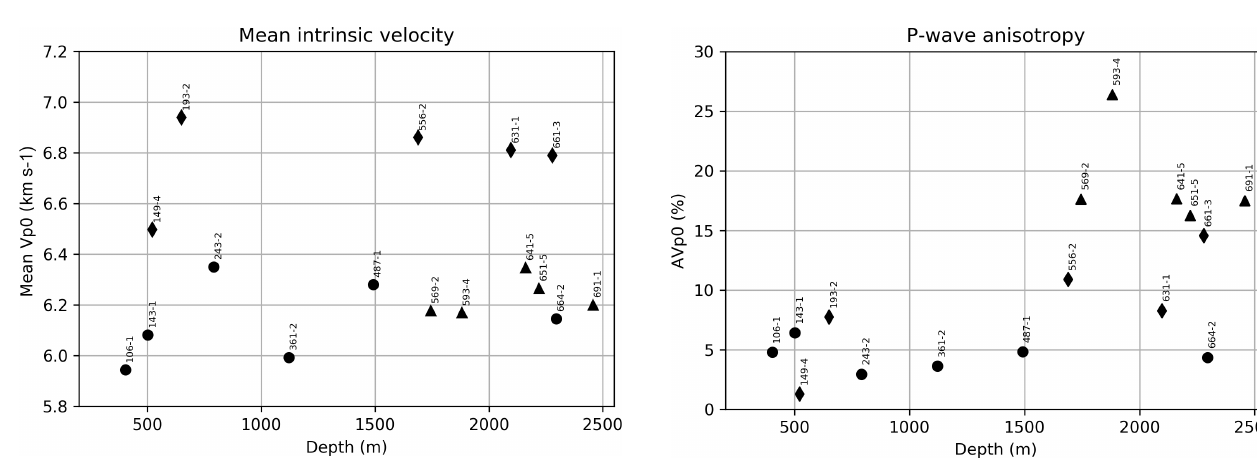
Figure 9. Seismic anisotropy measured in 16 rock samples from the COSC-1 borehole plotted at the respective sample depth. Mark- ers correspond to simplified lithological classes such as mafic amphibole-rich units ( (cid:7) ), felsic gneisses and metasandstone ( • ), and mica schist ( (cid:78) ).